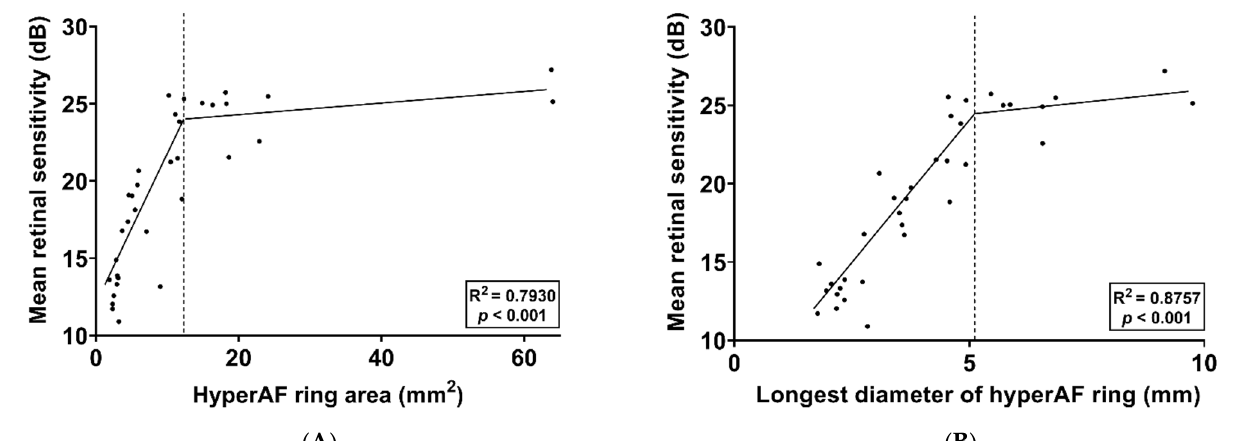
Figure 4. Scatterplots with segmented linear regression analysis showing the correlation of the mean retinal sensitivity with the hyperautofluorescent (hyperAF) ring area ( A ) and the longest diameter of the hyperAF ring ( B ). The breakpoints were 12.83 mm 2 in the relationship between the hyperAF ring area and mean retinal sensitivity and 5.21 mm in the relationship between the longest diameter of the hyperAF ring and mean retinal sensitivity.